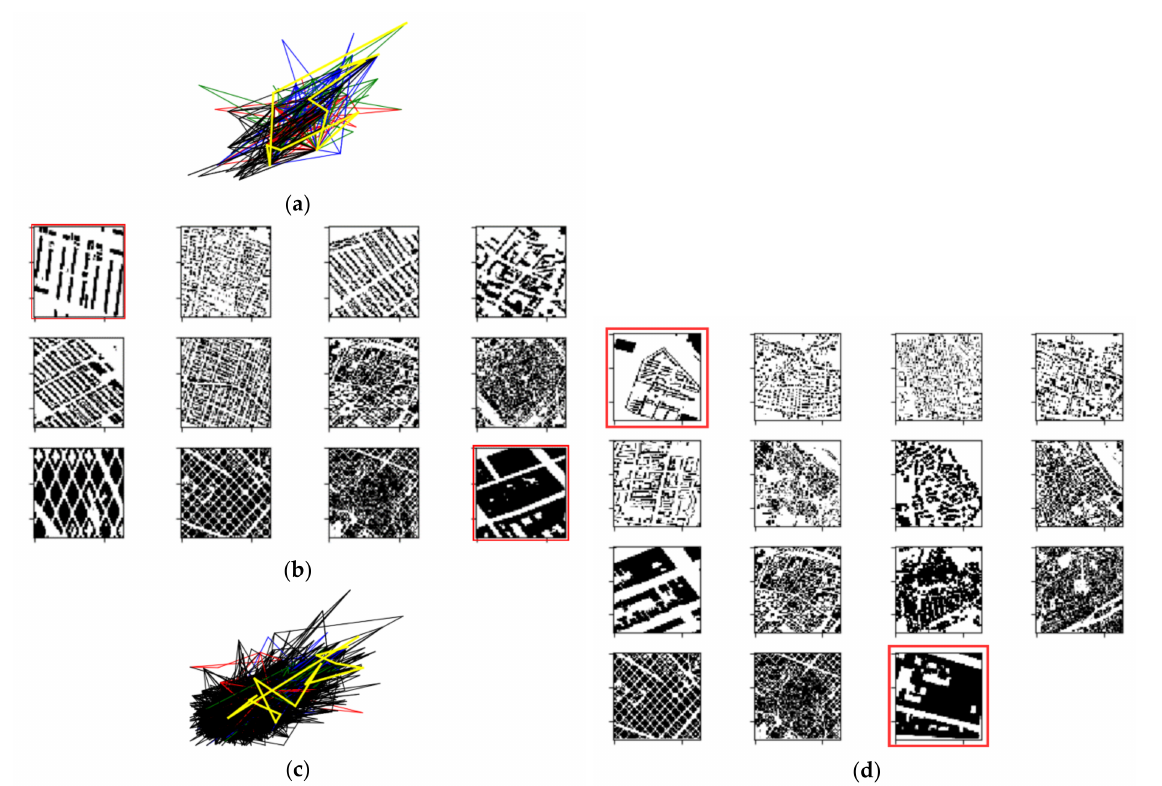
Figure 12. Results of Test 3. Traversing the graph between two data samples. The starting and ending data samples are marked in red in both subfigures ( b , d ). The data samples show the data points that match the ones on the graph traversal shown in ( a , b ). The subfigures ( a , c ) show the shortest path depicted in yellow in a three-dimensional scene.